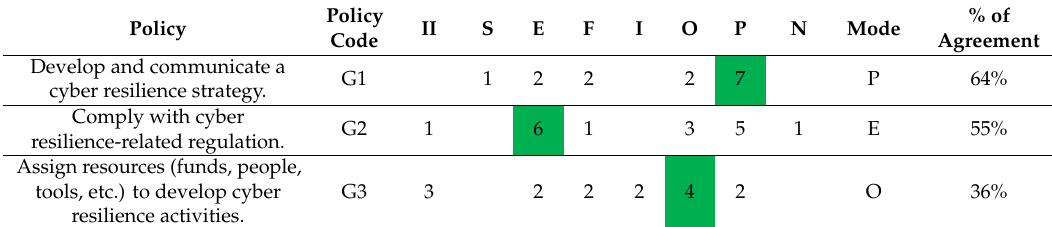
Table 3. Governance policies’ progression